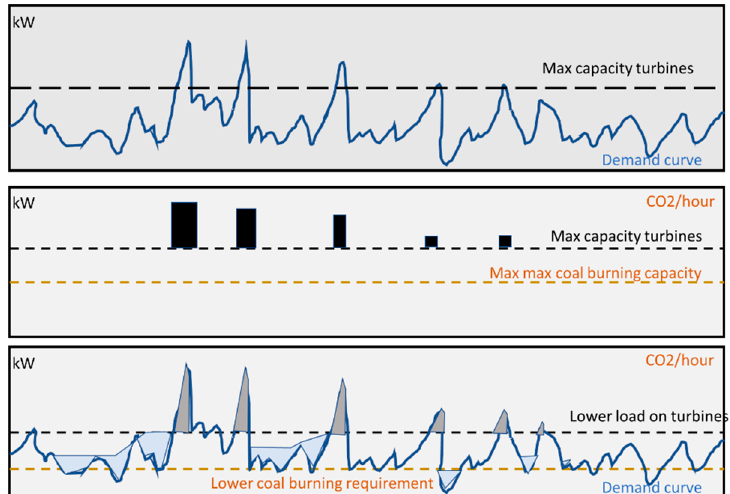
Figure 3. The impact of energy flexibility on CO 2 emissions. Upper: A load curve showing peaks that extend beyond the capacity of the existing turbines at plant. Middle: Corresponding chart showing the need for generator set activation to cater for the consumption peak. The plant is burning coal at maximum rate to support maximum electricity generation for turbines. Bottom: Energy flexibility caters for peak shaving and valley filling. Turbines do not need to cover for the highest peaks and the resulting coal-burning load can be reduced.